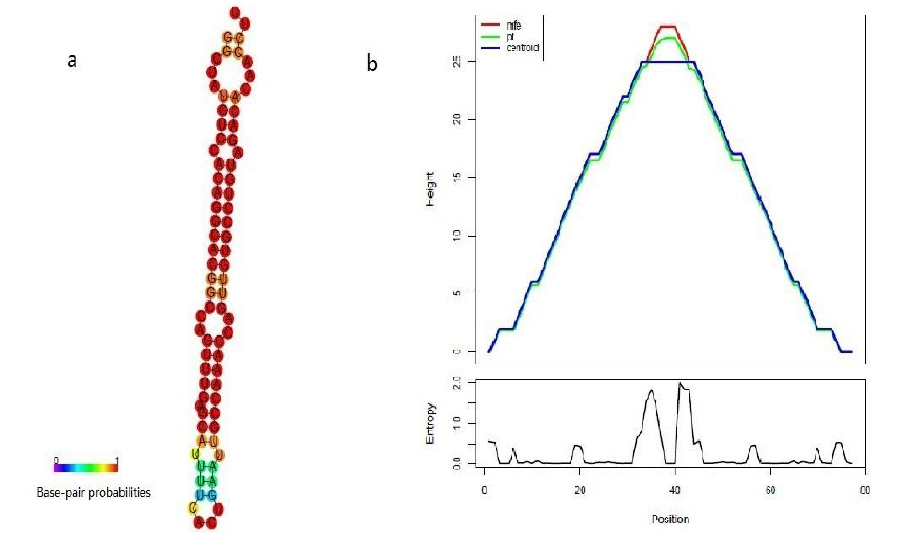
Figure 2. Hairpin structures of Novel_miR_7 predicted using RNAfold software. a: MFE structure drawing encoding base-pair probabilities. b: a mountain plot representation of the MFE structure, the thermodynamic ensemble of RNA structures, and the centroid structure, the positional entropy for each position was also